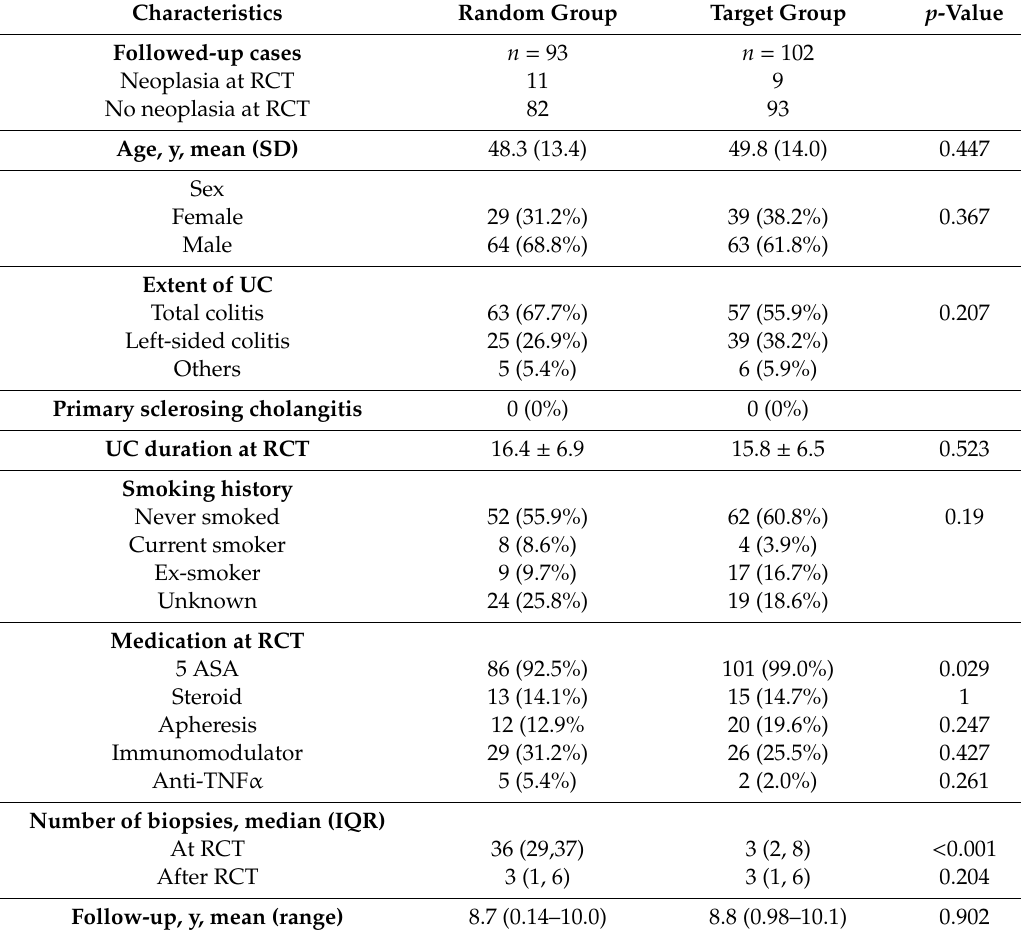
Table 1. Background characteristics of followed-up patients in both